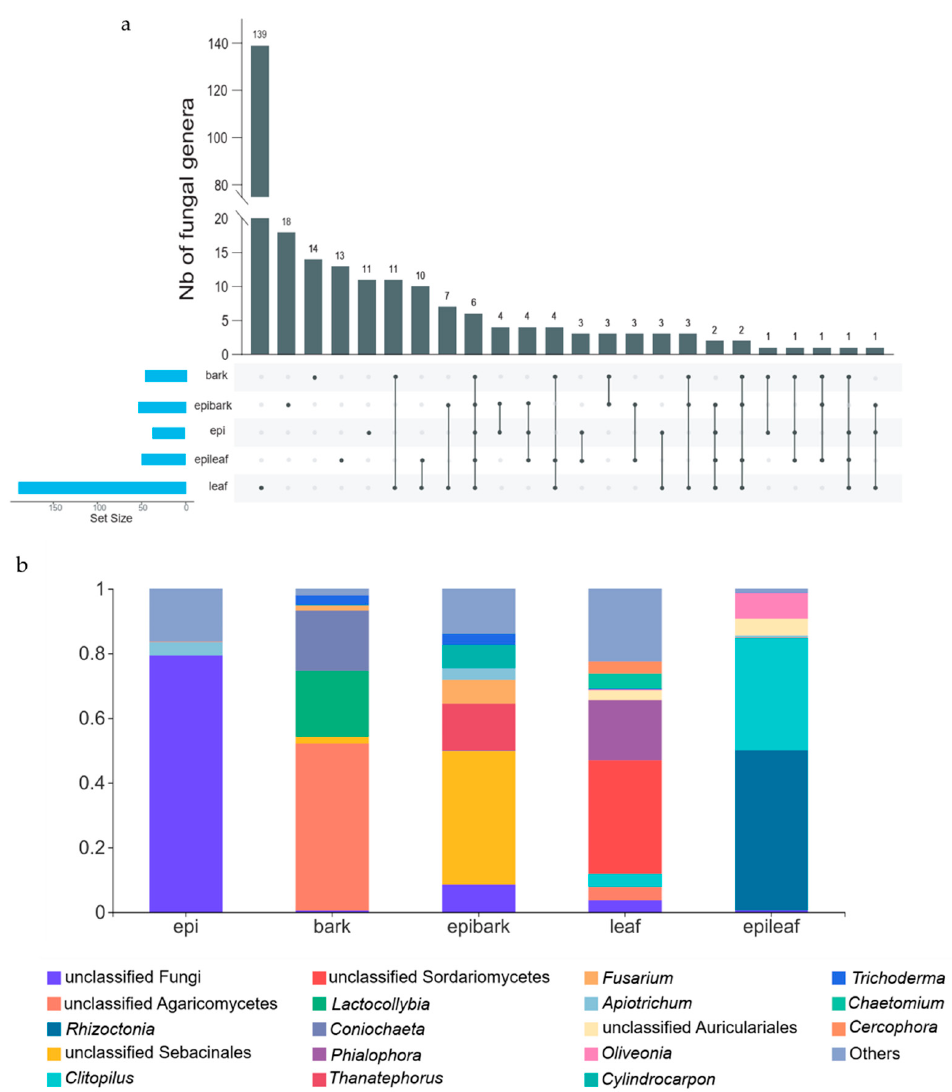
Figure 3. Fungal genera shared among different protocorms and substrates ( a ); fungal community compositions of protocorms and substrates at the genus level ( b ). epi: protocorms in vitro germinated on MS1 medium; bark: pine bark substrate; epibark: protocorms ex situ germinated on pine bark; leaf: rotten oak leaf substrate; epileaf: protocorms ex situ germinated on rotten oak leaf.